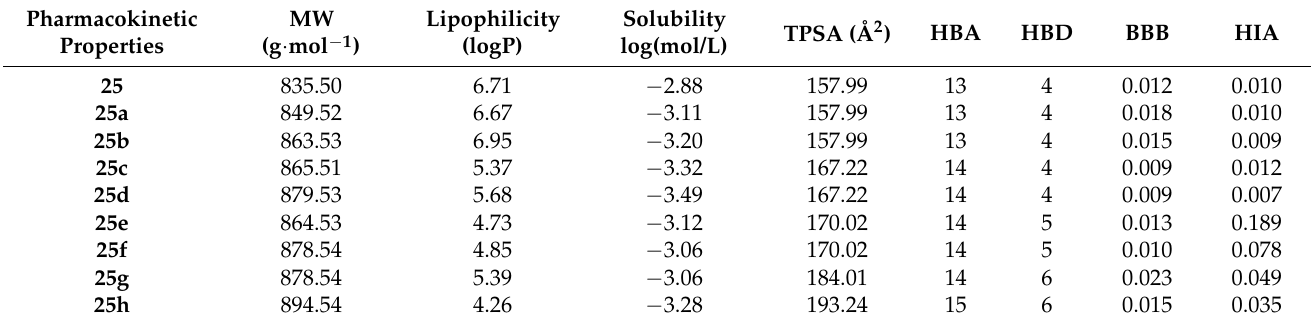
Table 4. Pharmacokinetic and ADME properties of the designed molecules and the lead compound evaluated using AdmetSAR and Osiris property